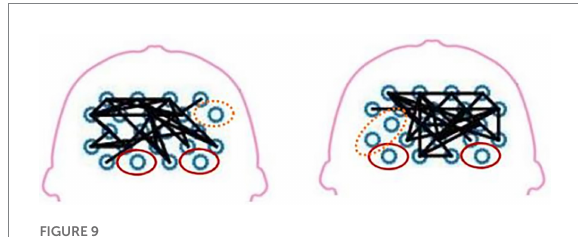
FIGURE 9 Network topologies of the test brain scope of two patients.